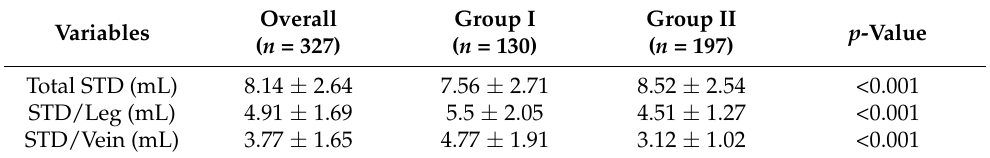
Table 3. Sclerosant amounts between MOCA (Group I) and combined EVLA and MOCA (Group II). Variables